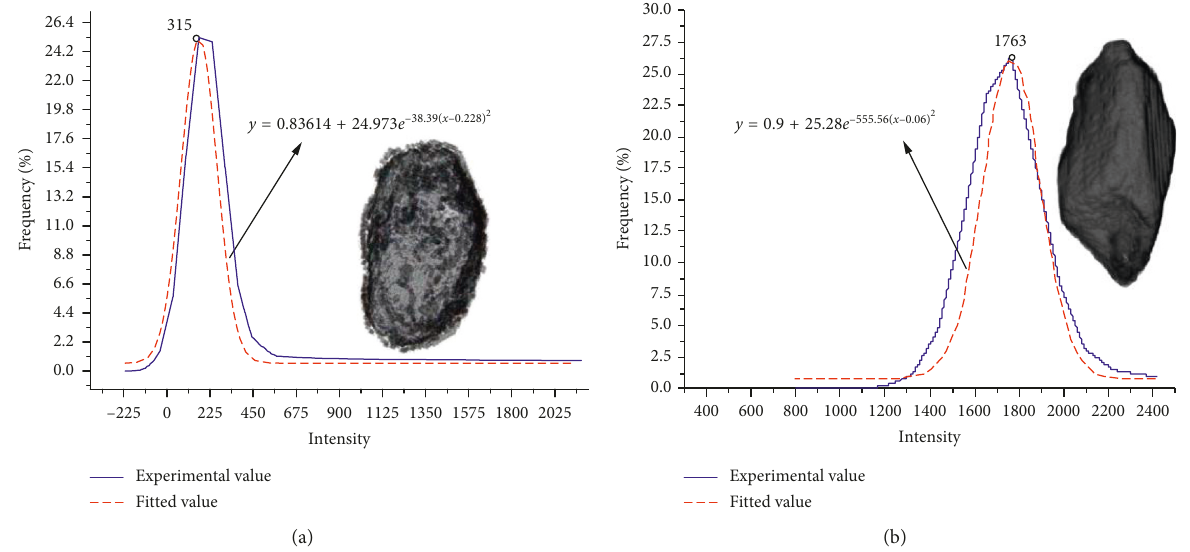
Figure 7: Intensity-frequency distribution curves and 3D volume-rendering images for the selected single-phase particles. This figure presents (a) the coal particle and (b) the gangue particle.